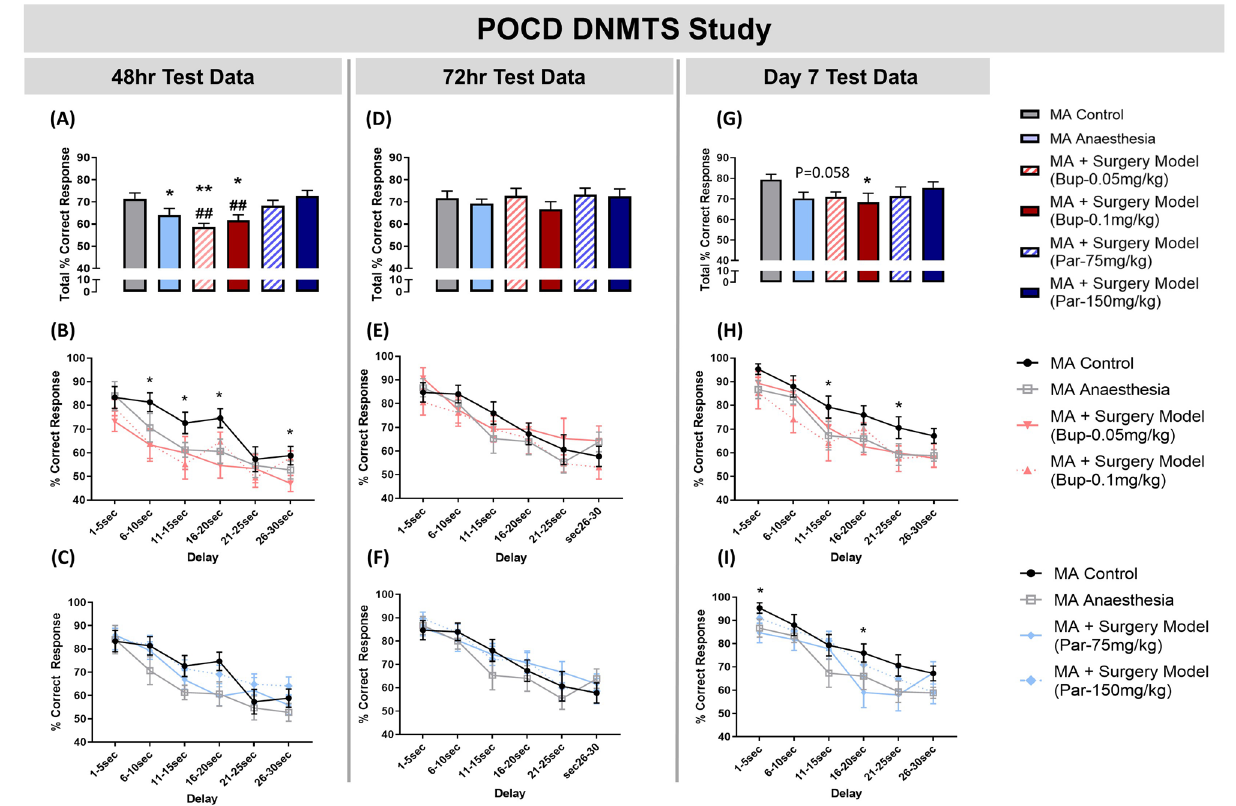
Figure 2. Paracetamol (Par) treatment appears to recover POCD in the DNMTS. Results at 48 h test-point showed: ( A ) MA rats exposed to anaesthetic only or which underwent surgery (MA + Surgery Model) treated with Buprenorphine at 0.05 mg/kg, i.p. or 0.1 mg/kg, i.p. were impaired in the DNMTS task compared to MA controls. In contrast, MA animals treated with Par-75 mg/kg, s.c. or Par-150 mg/kg, s.c. were not impaired in the task compared to MA controls; ( B ) Examination of the Bup groups compared to control groups across delay length showed that surgery model groups treated with Bup-0.05 mg/kg or Bup-0.1 mg/kg were impaired at 6–10 s, 11–15 s, 16–20 s and 26–30 s time bins; ( C ) Examination of the Par groups compared to control groups across delay length showed that surgery model groups treated with Par-75 mg/kg or Par-150 mg/kg did not have any delay-induced impairment. Results at 72 h test-point showed: ( D ) No differences were observed between groups; ( E ) and ( F ) No group differences were observed following examination of performance across different delay lengths. Results at Day 7 test-point showed: ( G ) MA animals which underwent the surgery model treated with Bup-0.1 mg/kg were significantly impaired compared to MA Controls. Par treatment (75 mg/kg or 150 mg/ kg) to surgery model animals prevented long lasting cognitive impairments; ( H ) MA + Surgery Model groups treated with Bup (0.05 mg/kg or 0.1 mg/kg) were impaired at delay time lengths 11–15 s to 21–25 s compared to MA control; ( I ) MA + Surgery Model group treated with Par-75 mg/kg were impaired at delay lengths 1–5 s and 16–20 s compared to MA control. Histograms represent Total % Correct response (the mean group performance across all delay lengths in the DNMTS task ± SEM), n = 5–11 per group. DNMTS trials were sorted by performance according to length of delay on individual trials and were grouped according to 5-s intervals (1–5, 6–10, 11–15, 16–20, 21–25, and 26–30) represented by line graphs (mean ± SEM). Two-way ANOVA followed by Fisher’s LSD analysis **p < 0.01, *p < 0.05 vs. MA control; ## p < 0.01 vs. MA + Surgery Model (Par-150 mg/kg) control (Table 1: p < 0.05 for both). IL-10 levels were significantly increased in MA animals which underwent surgery and were treated with Bup-0.1 mg/kg compared to MA animals exposed to anaesthesia only (Table 1: p < 0.05). Moreover, IL-13 levels were significantly increased in MA animals which underwent surgery and were treated with Bup-0.1 mg/kg compared to MA animals exposed to anaesthesia only (Table 1: p < 0.05) and MA control animals (Table 1: p < 0.01). IL-6 levels were significantly increased in MA animals which underwent surgery and were treated with Bup-0.1 mg/kg compared to MA controls (Table 1: p < 0.05). Interestingly, MA animals which underwent the surgery model and were treated with Bup-0.05 mg/kg or Bup-0.1 mg/kg had sig- nificantly higher plasma IL-5 levels compared to MA controls (p < 0.05 and p < 0.01, respectively). Paracetamol increases hippocampal anti‑inflammatory cytokines following surgery.. Hip- pocampi were collected at the same time as plasma for the same cytokine analysis. Complete results are pre- sented in Table 2. Briefly, Fisher’s LSD test revealed that MA animals which underwent surgery and were treated